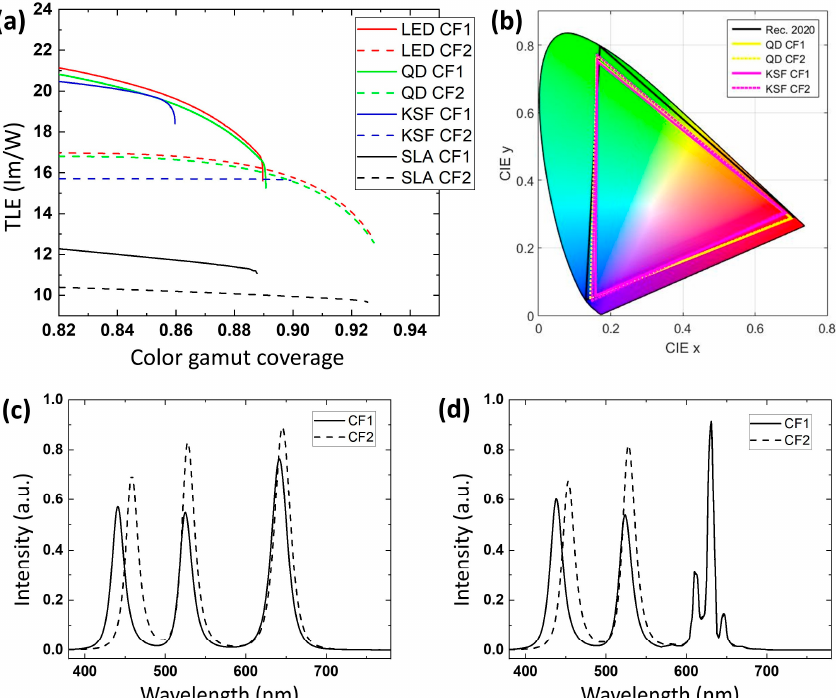
Figure 11. ( a ) Pareto Fronts of hybrid-backlight in-plane switching liquid-crystal display (IPS LCDs) with different red emitters and color filters. ( b ) Simulated color gamut for optimized QD- and KSF phosphor-based hybrid LCDs with different color filters. Optimized emission spectra of ( c ) QD- and ( d ) KSF phosphor-based hybrid backlight without any modulation for the two different color filters. Table 2. Optimized values of wide color-gamut IPS LCDs using different red emitters.